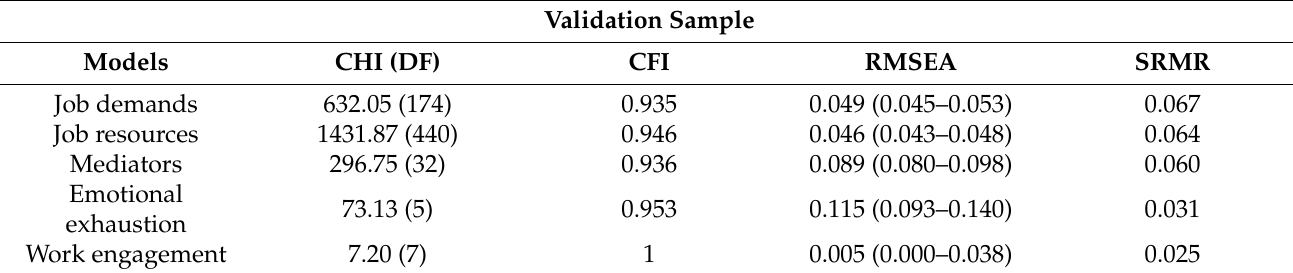
Table 5. Confirmatory factor analysis aggregated by demands, resources, mediators, and outcomes in validation sample (N = 1481).